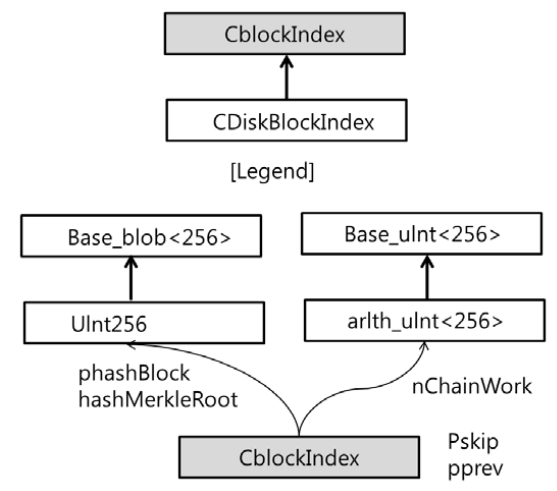
Figure 20. Figure 20. CBlockIndex.